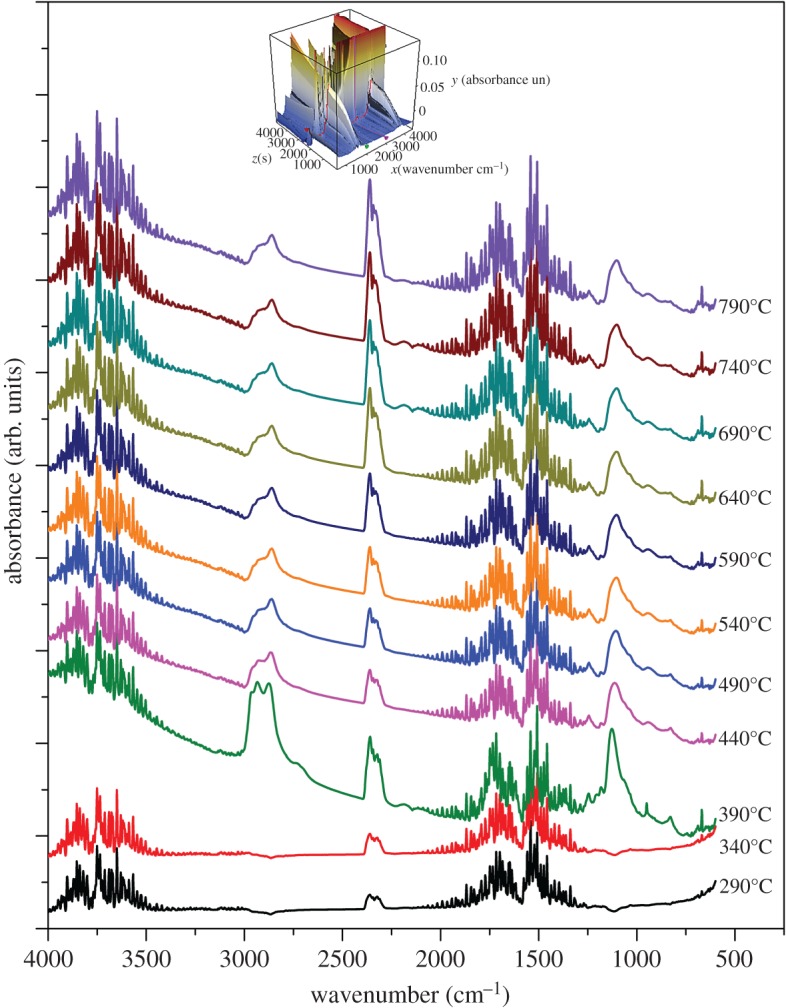
TG-FTIR spectra of CaCO3-based NIMs recorded at different temperatures.